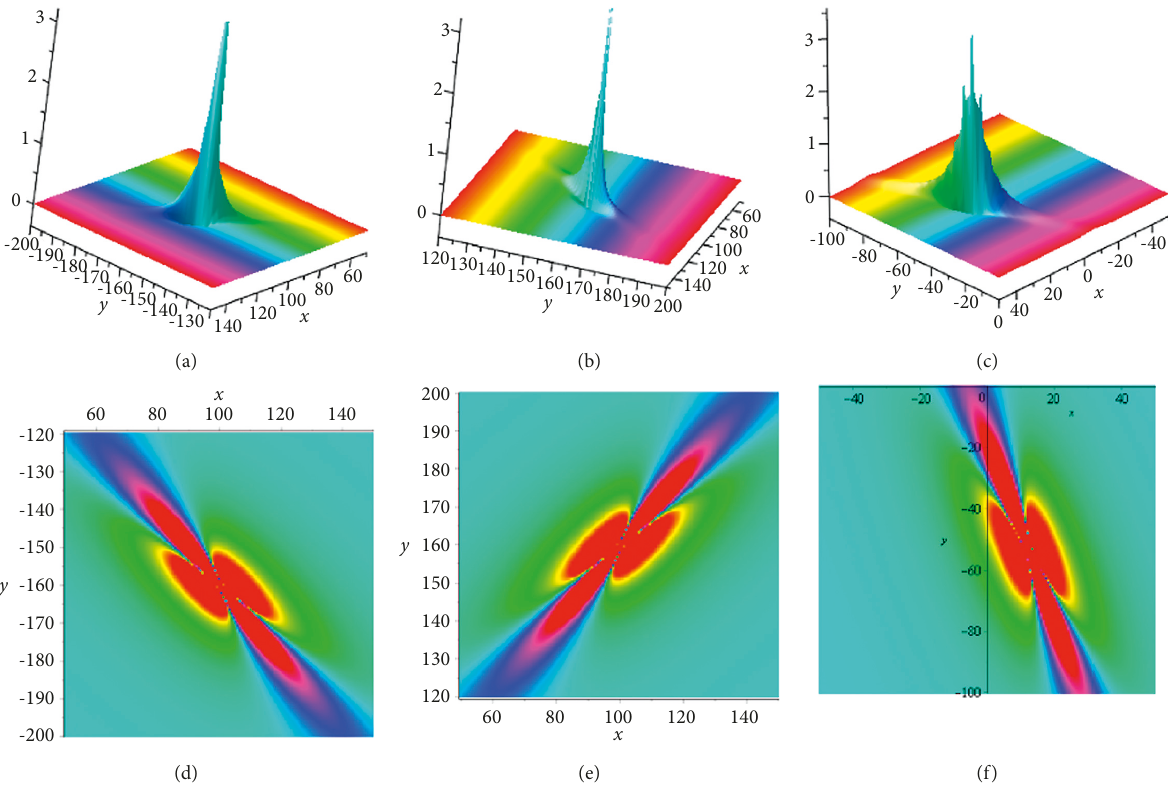
Figure 11: Plots of equation (61) by taking ϱ (c) f 3. (d) f 4. (e) f 5. (f) f